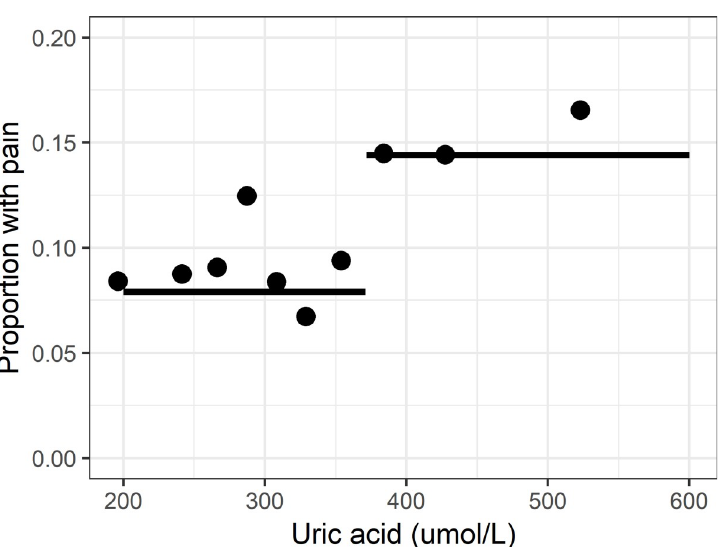
Fig 1. This figure where the dots represent deciles of SUA illustrates the best fitting threshold regression STEP model for the relationship between SUA levels and the proportion of females with intermittent hand pain in � 10 hand joints by each decile. It also demonstrates the estimated cut-off at SUA � 372 μ mol/L.